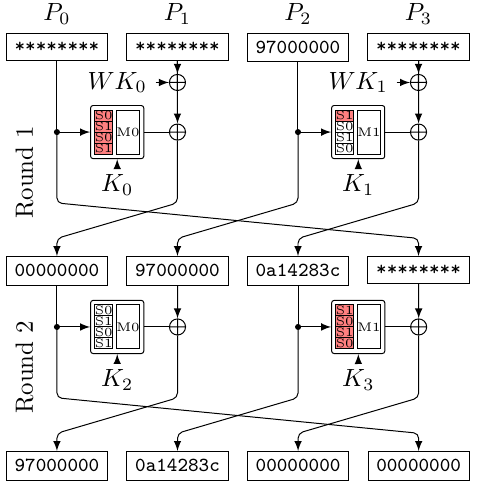
Figure 9: CLEFIA : Key-recovery for 2 initial